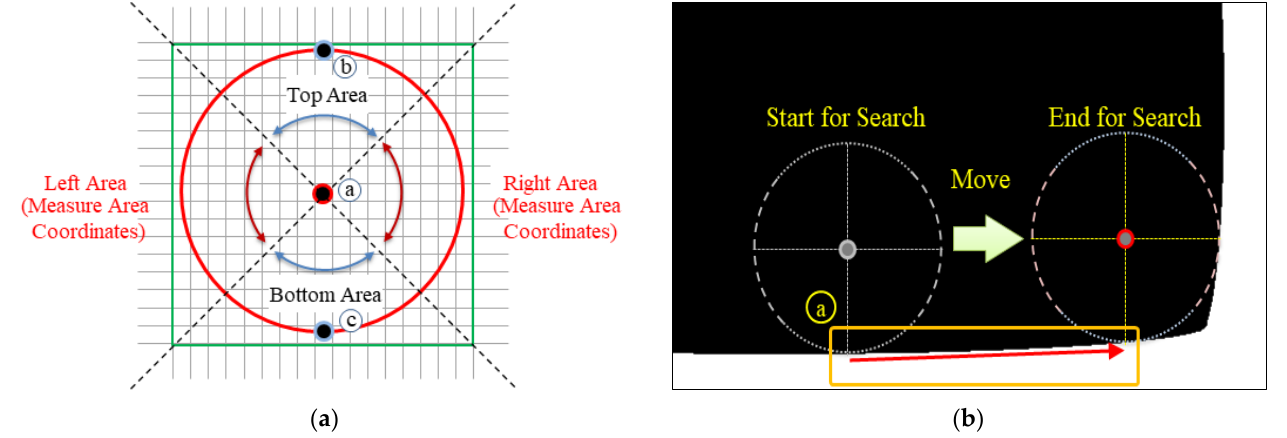
Figure 6. Concept of the circle-based reference point search algorithm. ( a ) Circle and function for reference point extraction ( ⓐ : center point A, ⓑ : top point B, ⓒ : bottom point C); ( b ) Object with curved components ( ⓐ : moving path A).